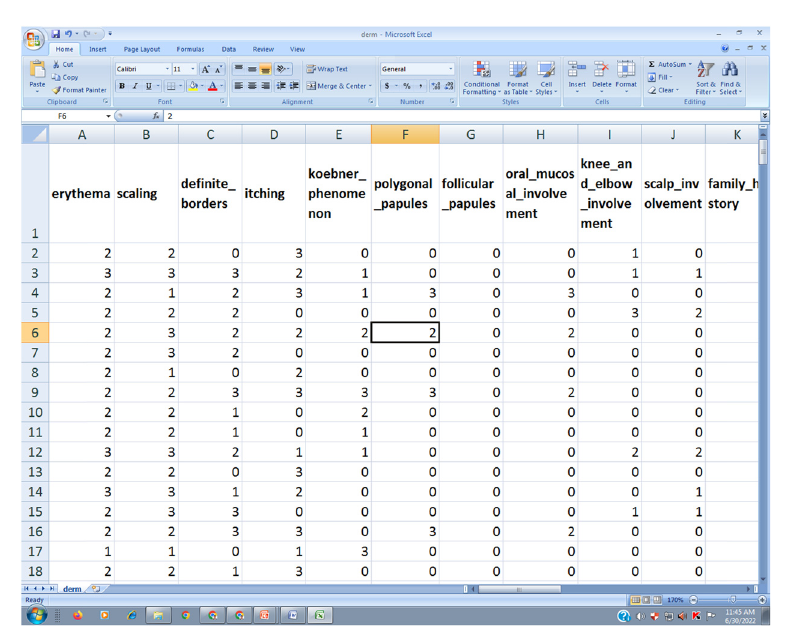
Figure 3: Input dataset